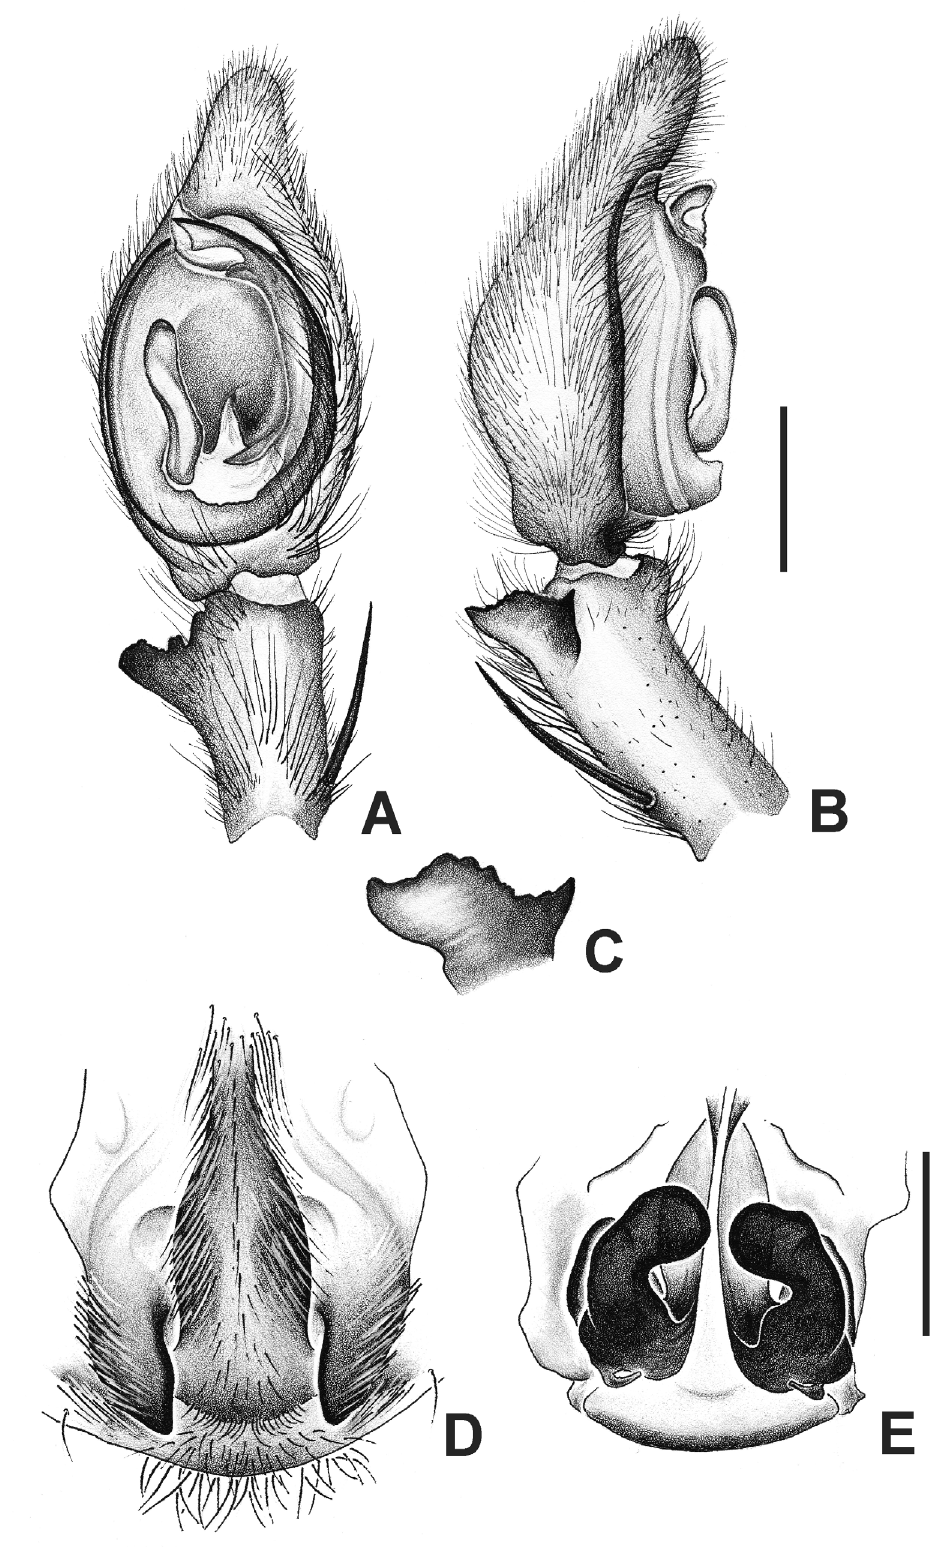
Fig. 9. Afroneutria quadrimaculata sp. nov. — A–C . Male palp. A . Ventral view. B . Retrolateral view. C . Retrolateral tibial apophysis, lateral view. — D–E . Female genitalia. D . Epigynum, ventral view. E . Vulva, dorsal view. Scale bars = 2